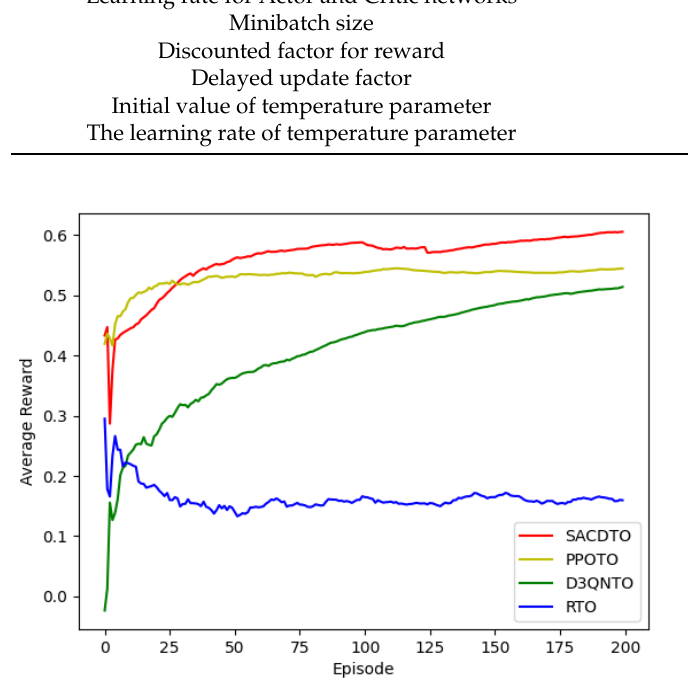
Figure 2. Convergence Analysis of Graph.